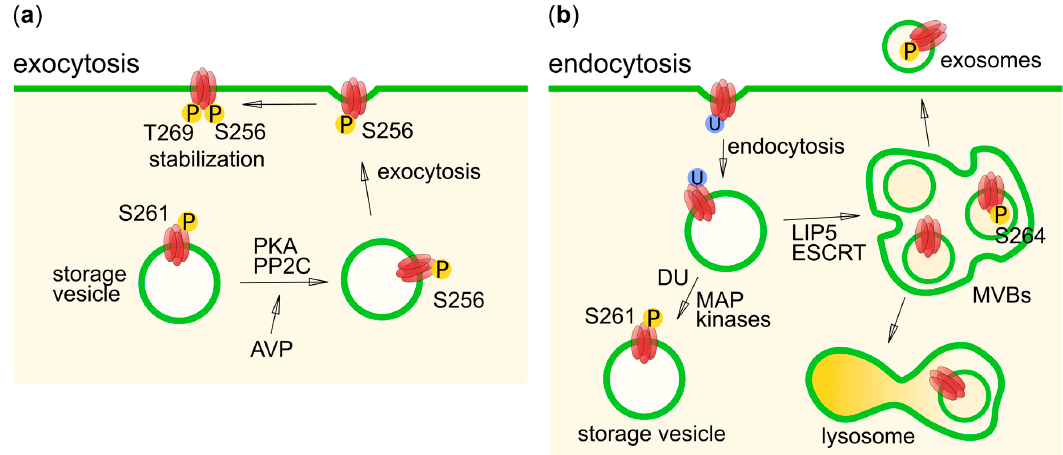
Figure 4. Schematic figure of the role of phosphorylation and ubiquitination in trafficking of AQP2 in the kidney collecting duct principle cell. AQP2 is represented in red, phosphorylation in yellow and ubiquitination in blue. DU stands for de-ubiquitination. ( a ) AQP2 exocytosis. Arginine vasopressin (AVP) stimulation results in activation of PKA and protein phosphatase 2C (PP2C), which phosphorylate S256, and dephosphorylate S261, respectively. The vesicle then fuses with the apical membrane resulting in an increase in urine concentration. The protein can be further stabilized in the plasma membrane by an additional phosphorylation of T269. ( b ) AQP2 endocytosis. Upon ubiquitination, AQP2 is internalized and may be recycled (when phosphorylated at S261) or targeted to multi-vesicular bodies (MVBs), with the help of LIP5 and the ESCRT machinery. Once in MVBs, fusion of the whole